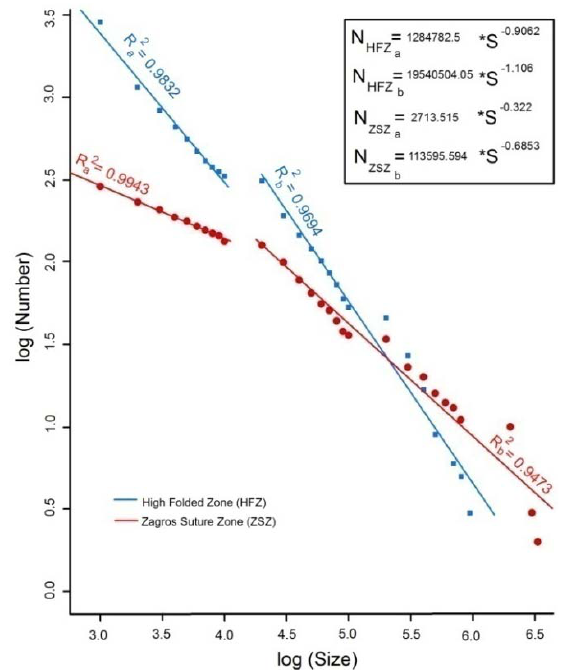
Figure 11. Distribution plot of 290 landslides within the Zagros Suture Zone (ZSZ) and 2,900 landslides within the High Folded Zone (HFZ).